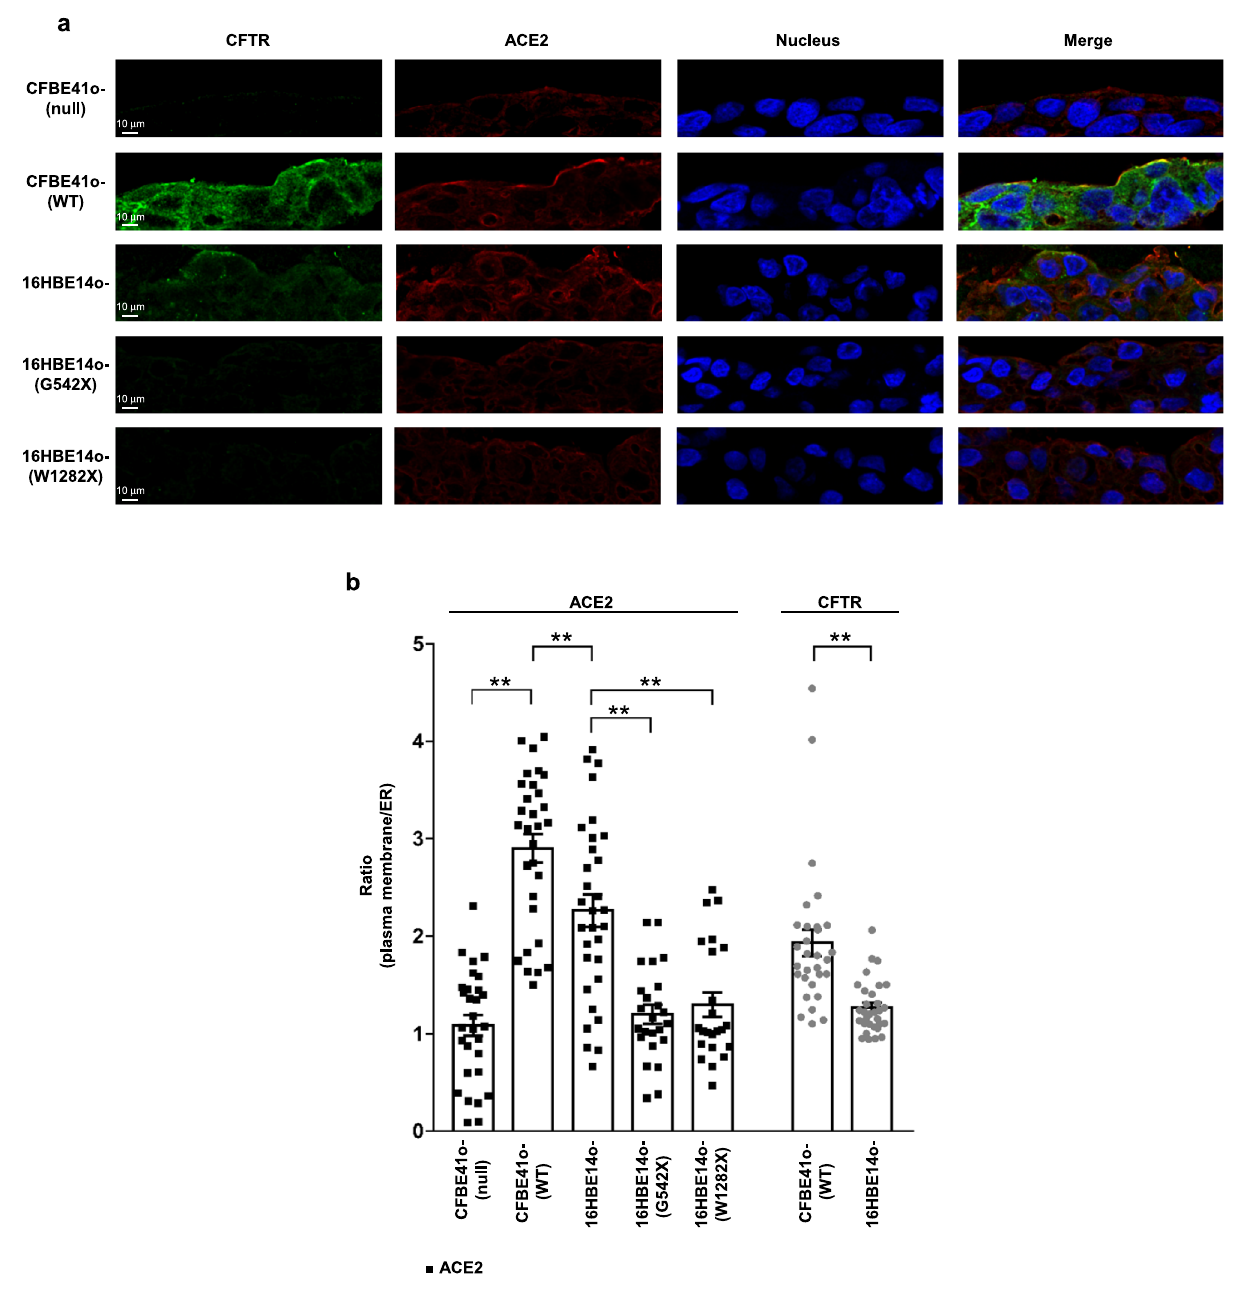
Fig. 4 | Intracellular distribution of ACE2 and CFTR in polarized bronchial epithelial cells. a Representative images of immuno fl uorescence detection of CFTR (green), ACE2 receptor (red) under basal conditions in polarized CFBE41o- (null), CFBE41o- expressing wild-type CFTR (WT), 16HBE14o- cells and in gene- edited 16HBE14o- cells carrying biallelic G542X-CFTR mutations (G542X) or W1282X-CFTR (W1282X), respectively. Images were acquired with confocal laser scannerOlympusFV3000microscope(scalebar:10 µ m).Hoechststainwasusedto fl uorescentlylabelthecellnuclei(blue). b Thescatterplotwithbarsrepresentsthe